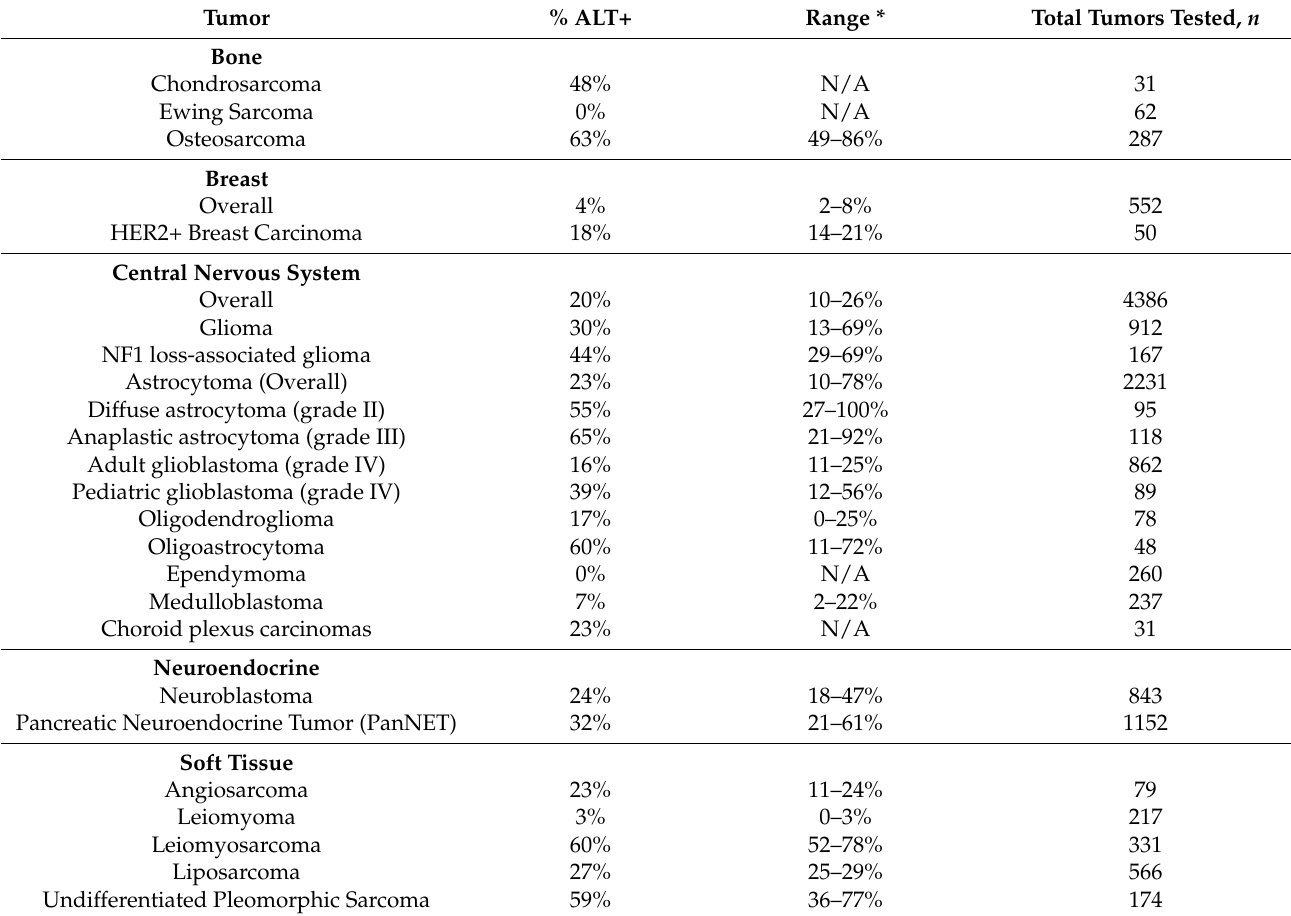
Table 2. Prevalence of ALT positivity in Human